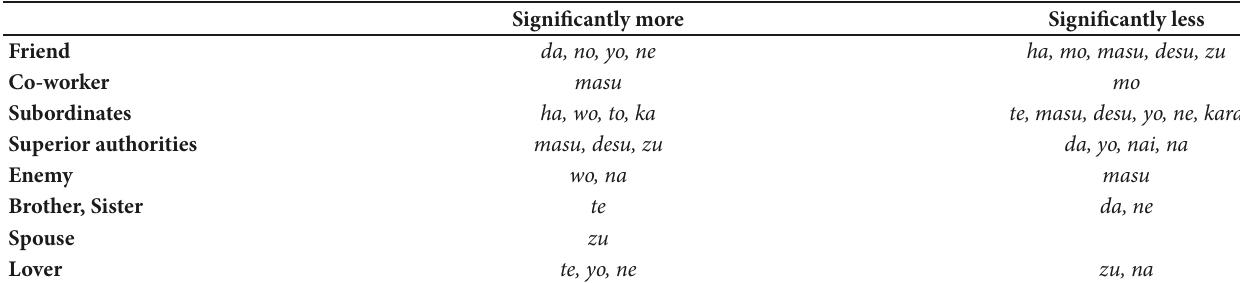
Table 4: Significant words in division of relationships between speakers and